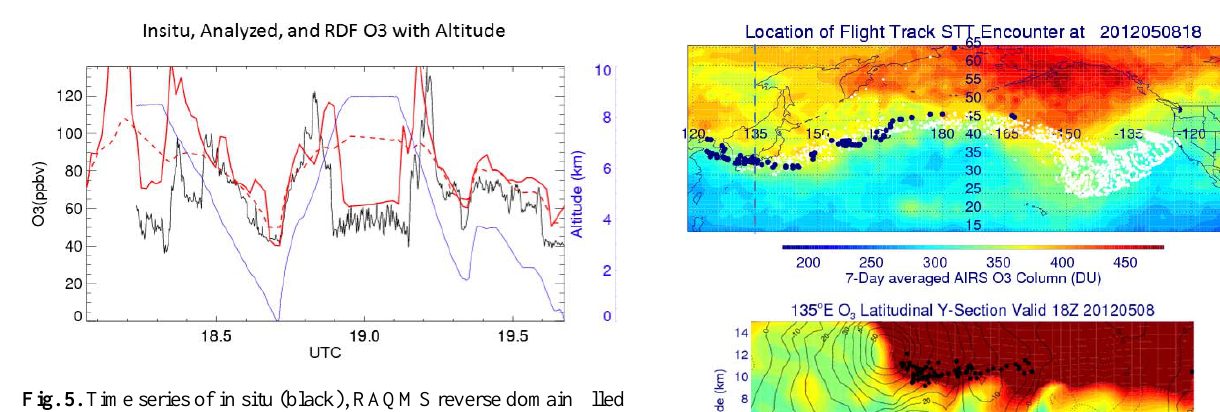
Fig. 5. Time series of in situ (black), RAQMS reverse domain filled (RDF) (solid red), and RAQMS-analyzed (dashed red) O 3 (ppbv) for AJAX flight on 14 May 2012. The in situ O 3 data acquisi- tion starts during the transit to the San Joaquin Valley (SJV) site. The first vertical profile is over the SJV and second vertical profile over the offshore location. The RDF approach provides much better agreement with the in situ observations.